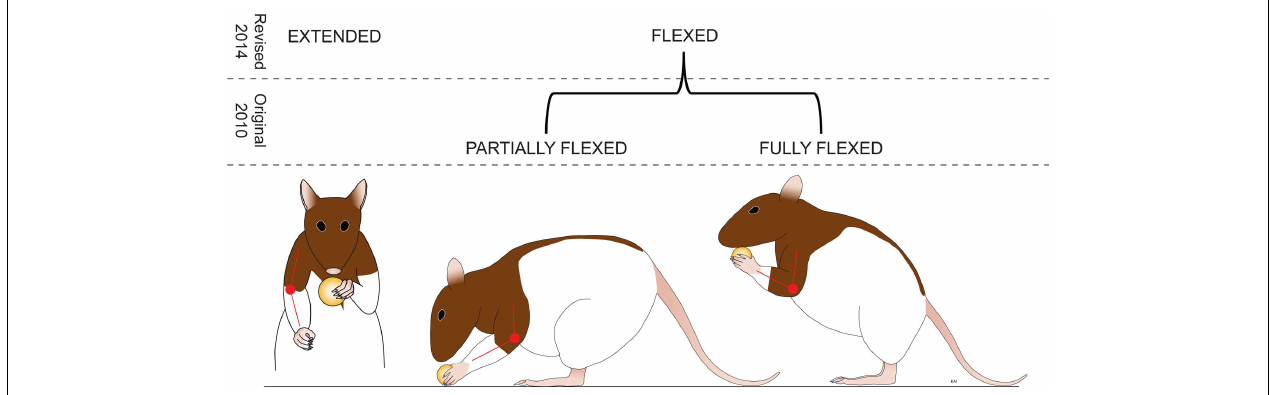
angle of more than 160°. Flexed –The elbow is flexed with an angle of less than 160 ° . (Revisions of the IBB scale from the JoVE 2010 version are highlighted in italics.)